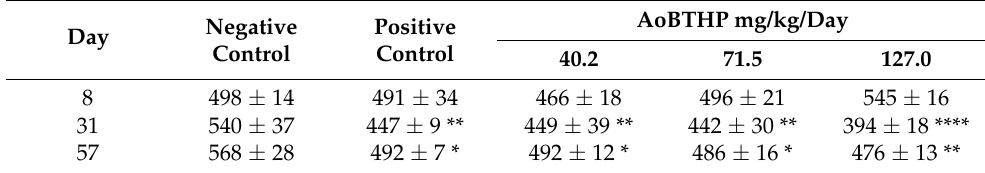
Table 4. Fasting glycemia values of animals (mean ± SEM).